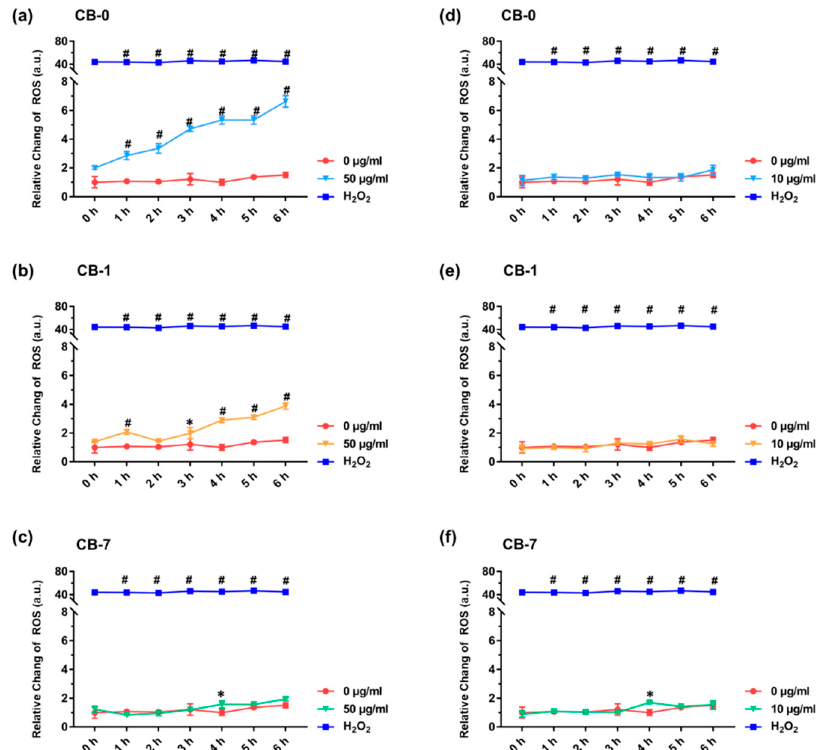
Figure 3. Determinations of intracellular ROS. Intracellular ROS production over time in J774A.1 cells upon CB particle treatment at 50 µg/mL ( a – c ) and 10 µg/mL ( d – f ) (n = 3). The untreated group was used as the negative control and 0.2% H 2 O 2 was used as the positive control. All controls are untreated groups. Statistical significance between groups: (*) p < 0.05 and (#) p < 0.001, relative to the untreated control. Abbreviations: ROS, reactive oxygen species.